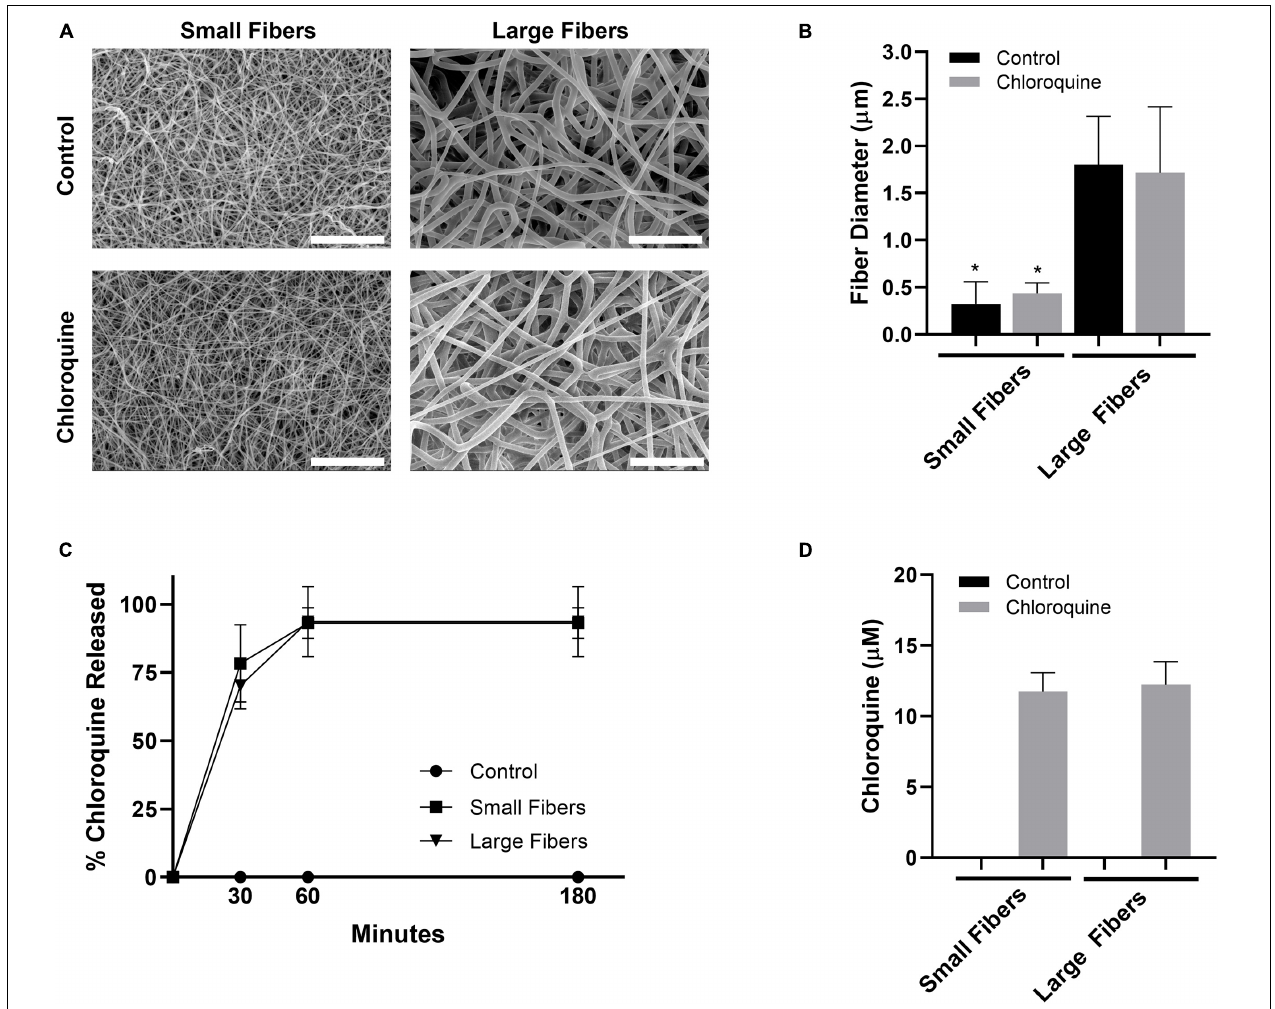
FIGURE 1 | Chloroquine incorporation into electrospun biomaterials results in uniform fibers that rapidly elute the additive. (A) Representative SEMs of the control and chloroquine-loaded biomaterials. Micrographs were acquired at 1,000 × magnification and scale bars are 30 µ m. (B) Fiber diameters of the electrospun biomaterials. Measurements ( n = 150) were taken in FibraQuant 1.3 software. (C) Percent chloroquine released from the biomaterials and (D) eluted chloroquine concentration at 3 h. There was no increase in concentration after 3 h. See Supplementary Figure 1 for the standard curve used to interpolate concentration ( n = 4) from absorbance. Graphs show mean ± standard deviation. * p < 0.0001 was determined using a Kruskal–Wallis and Dunn multiple-comparisons test. Raw data are available in Supplementary Spreadsheet 1